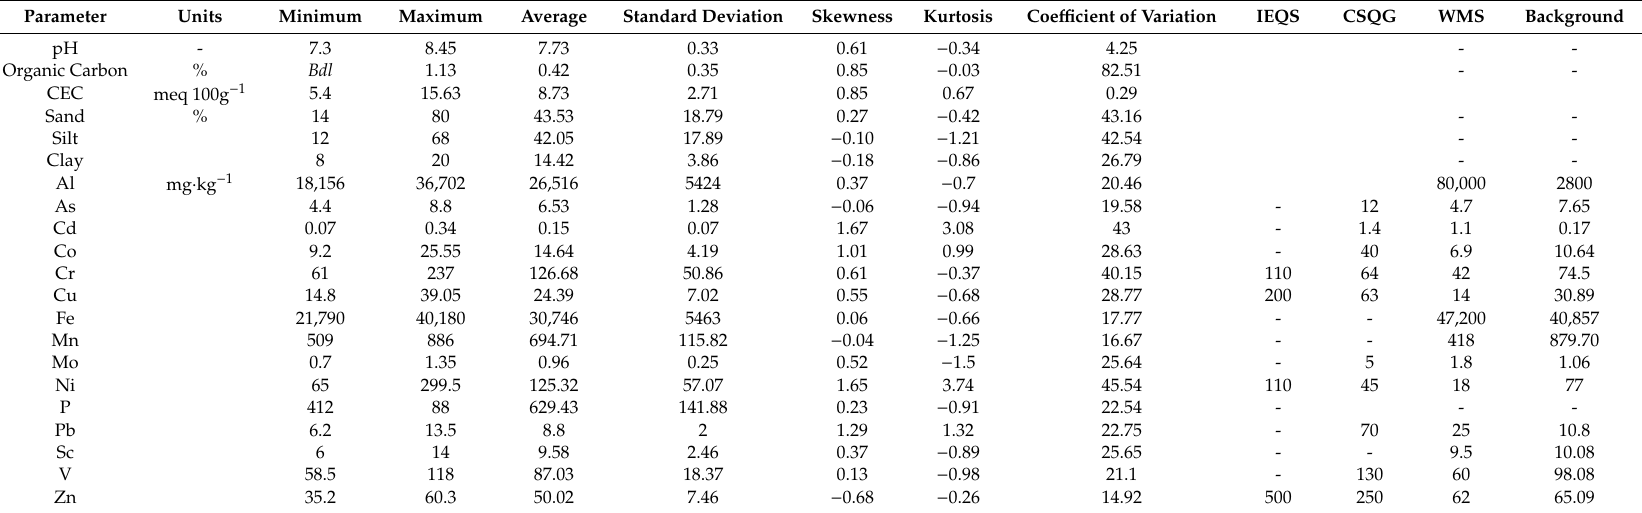
Table 1. Summary statistics of physical and chemical properties and potentially toxic elements (PTE) levels (mg · kg − 1 ) for the agricultural soil samples of Bandar Abbas County South District